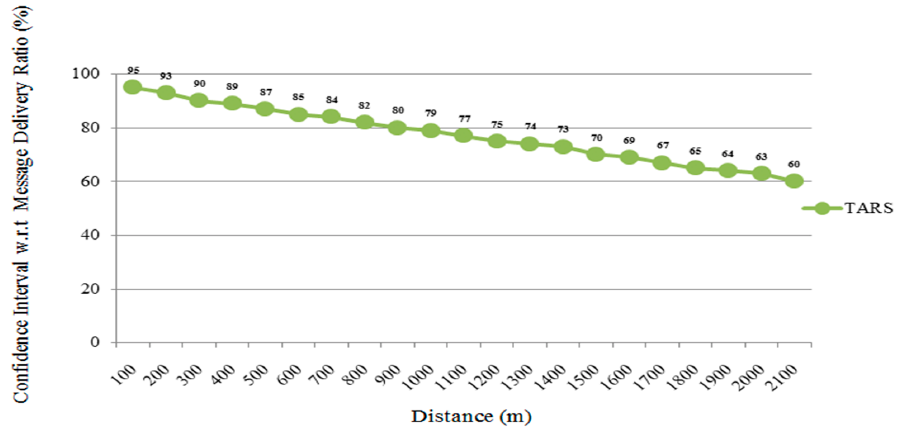
Figure 14. Confidence Interval w.r.t Message Delivery Ratio in the highway scenario.